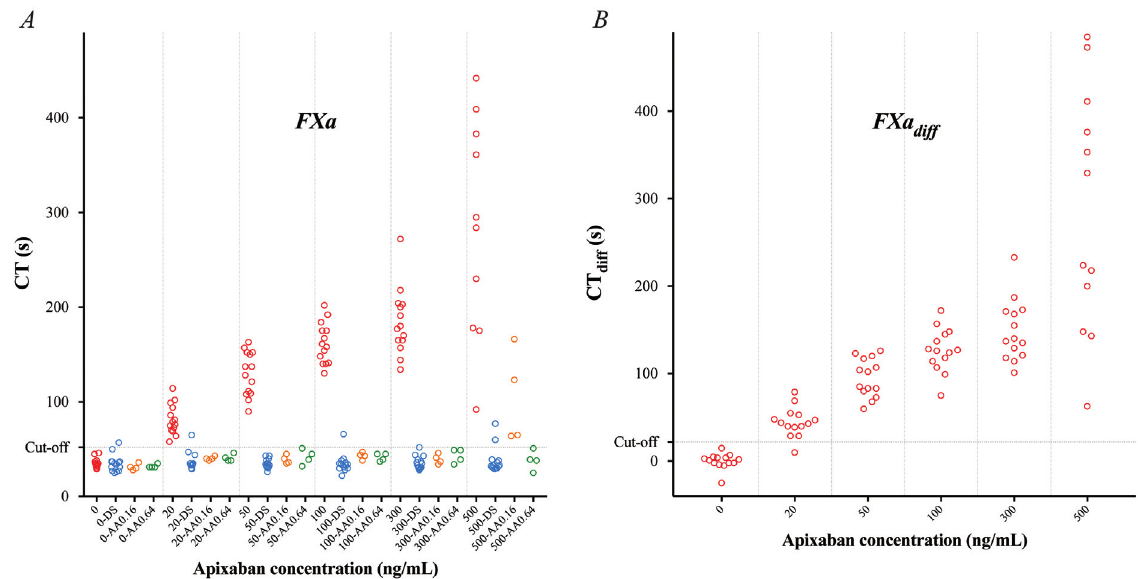
Fig. 2 Rotational thromboelastometry (ROTEM) analyses using the factor Xa (FXa) trigger – variables clotting time (CT) ( A ) and CT diff ( B ; the difference in CTwithout vs. with DOAC-Stop [DS]) – performed on blood samples from 14 healthy controls incubated with apixaban at estimated plasma concentrations 0, 20, 50, 100, 300, and 500ng/mL (red). Samples were analyzed in the absence or presence of DOAC-Stop (DS; blue) and andexanet alfa (AA; performed in samples from 4 out of 14 donors) – the latter in two different concentrations (0.16 [orange] and 0.64 [green] mg/mL). Cutoff line represents optimal receiver operating characteristics (ROCs) for discriminating between samples with apixaban concentration above or below 20ng/mL.